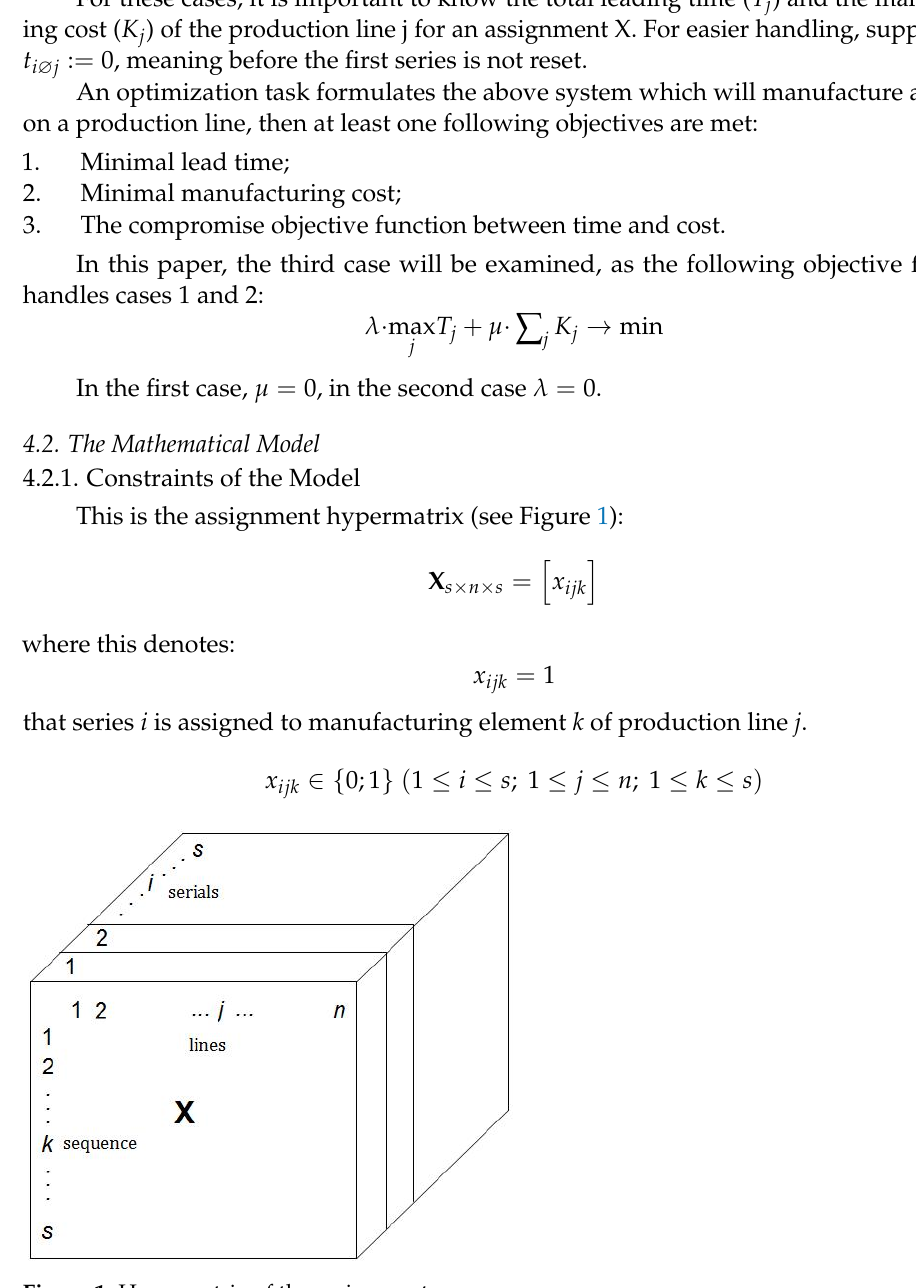
Figure 1. Hypermatrix of the assignment.